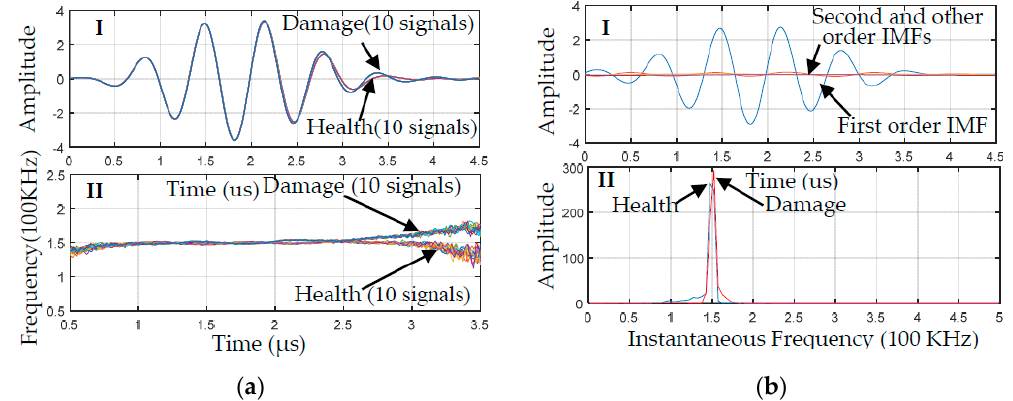
Figure 5. Instantaneous frequency and marginal spectrum of the Lamb wave packet with a center frequency of 150 kHz. ( a ) Sequence diagram and instantaneous frequency of the wave packet, and subfigure ( I ) shows the wave packet before and after damage; subfigure ( II ) shows the instantaneous frequency before and after damage. ( b ) The intrinsic mode function (IMF) and marginal spectrum of the wave packet. Subfigure ( I ) shows the IMFs after empirical mode decomposition (EMD) decomposition of the wave packet, and subfigure ( II ) shows the marginal spectrum of the wave packet before and after damage.